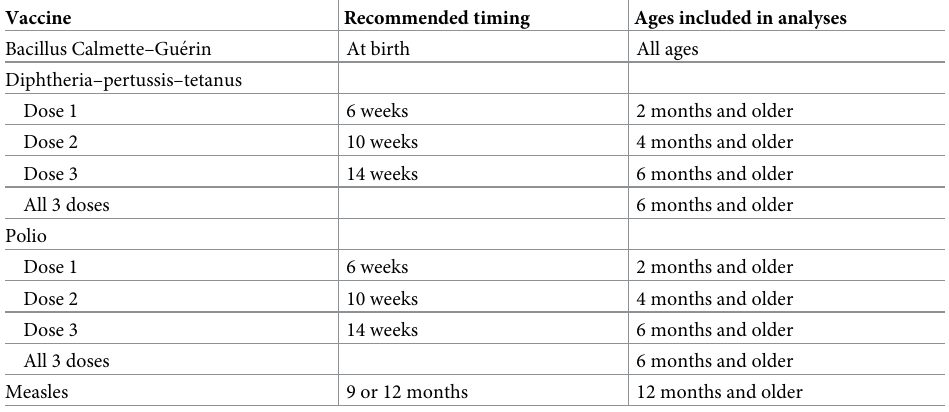
Table 1. Description of outcomes included in analyses assessing the association between drought and vaccination.